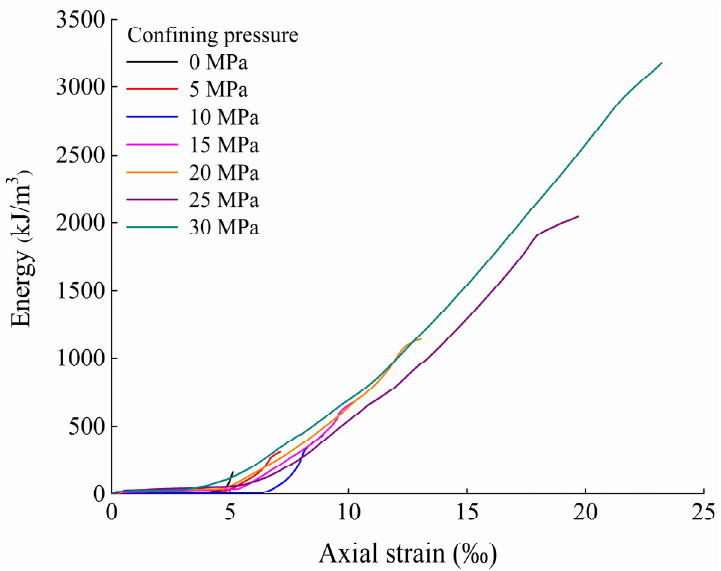
Figure 17. Variation law of the dissipated energy of marble with axial strain under different confining pressures at 0 thermal cycles.